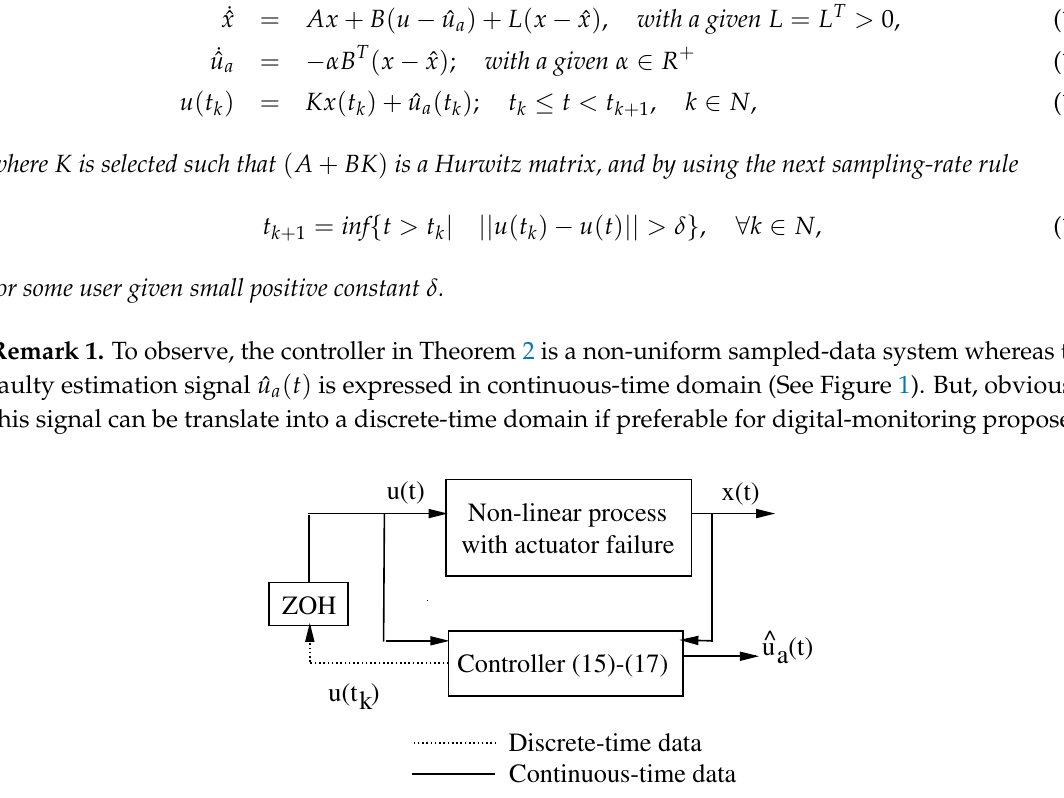
Figure 1. Schematic representation of the closed-loop system by using the Theorem 2 controller